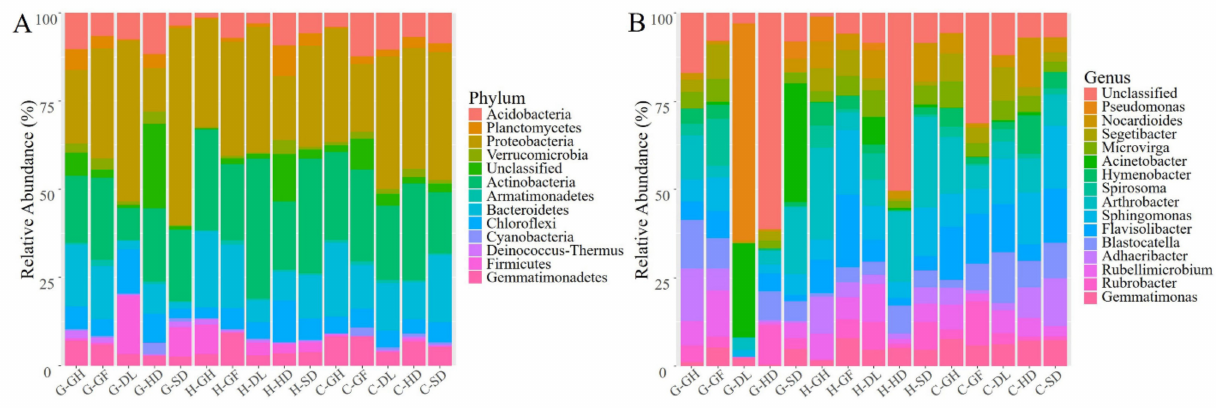
Figure 2. The bacterial composition of different habitats across 3 sites sampled from cold-desert, Qinghai–Tibet Plateau, China: ( A ) Relative abundance of the dominant bacterial phylum, ( B ) Relative abundance of the dominant bacterial genus are shown in stack plot. The relative abundances are based on the ≥ 97% similarity clusters of the